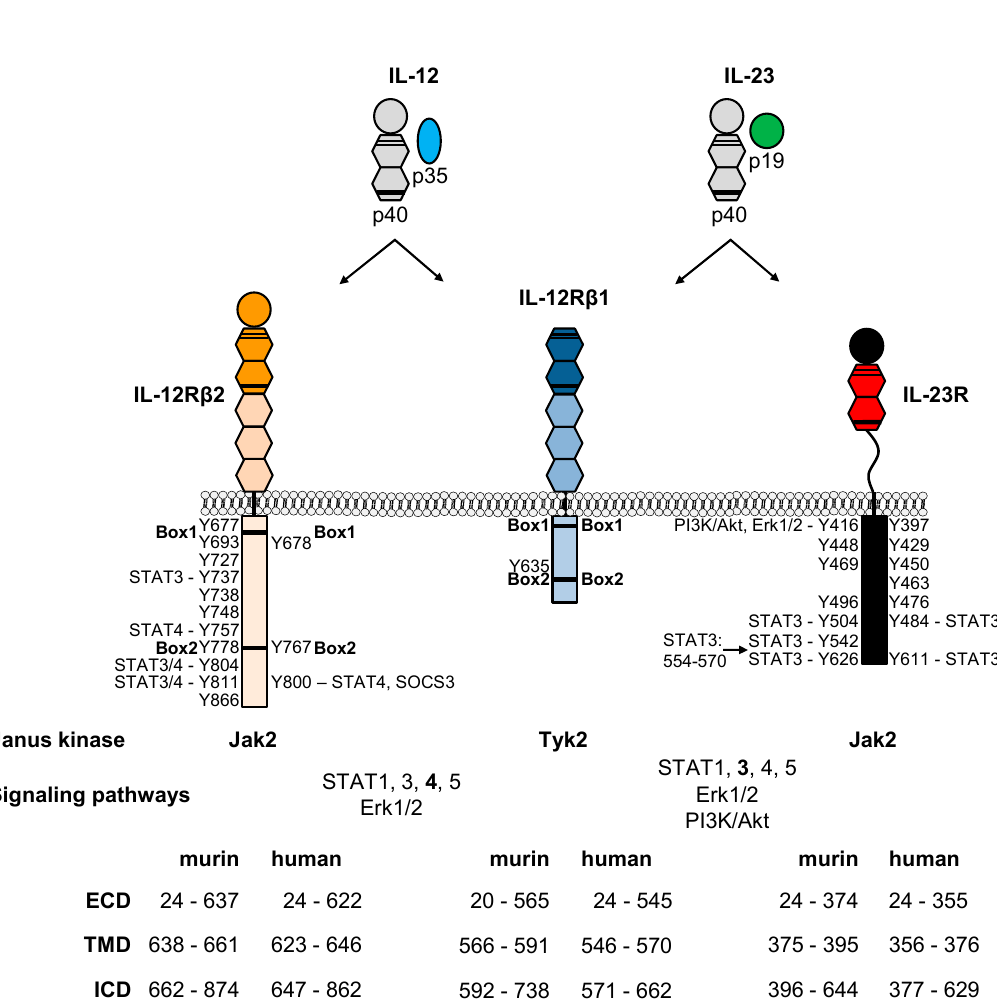
Figure 4. IL-12 and IL-23 receptor complexes and signal transduction. Schematic overview of IL-12 and IL-23 receptor complexes for mouse and human. Jak2 and Tyk2 are associated with the receptors. Box1 and Box2 motifs for Jak association and activation are highlighted. Tyrosine residues within the cytoplasmic domains are shown and STAT recruitment sites are highlighted. Intracellular signaling pathways induced by tyrosine-phosphorylation are indicated.